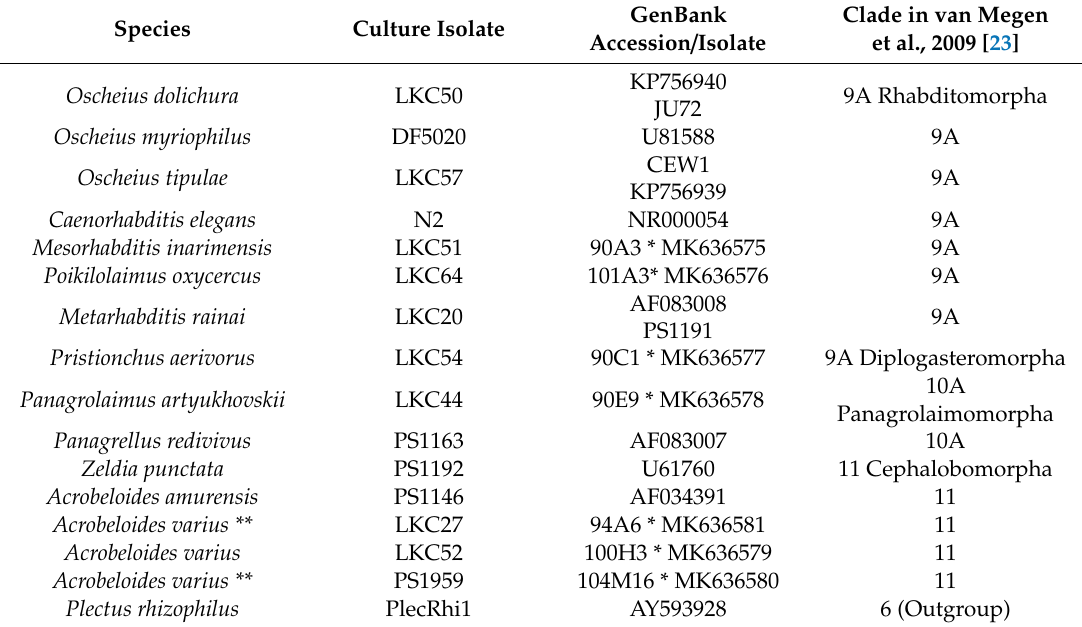
Table 1. Nematode cultures tested and represented in phylogenetic tree of Figure 1.